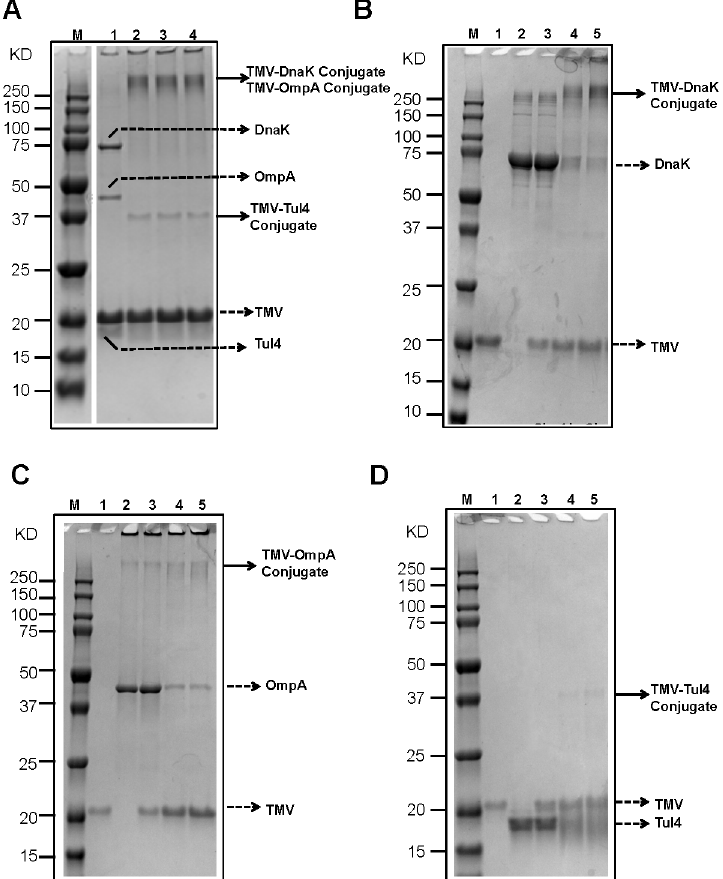
Fig 4. Conjugation of DnaK, OmpA and Tul4 Proteins of F . tularensis SchuS4 to TMV. Purified OmpA, DnaK and Tul4 proteins were combined with purified TMV and incubated with EDC and NHS for 0, 30 min, 1, or 2 hours as described in Methods section. Two μ g of TMV or recombinant proteins DnaK, OmpA, Tul4 or 4 μ g of the TMV-protein mixtures were resolved on an 8 – 16% SDS-PAGE gel to observe conjugation products indicated by changes in the molecular masses of the starting materials. (A) Conjugation of DnaK, OmpA and Tul4 to a single TMV virion to generate TMV-monoconjugate vaccine. The progress of conjugation process was observed over a period of time: Lane M = Precision Plus Dual Color standard (BioRad) Marker; Lane 1 = TMV-protein mix, 0 min; Lane 2 = TMV-protein mix, 30 min; Lane 3 = TMV-protein mix,1 hour; Lane 4 = TMV-protein mix, 2 hours. (B, C, D) Kinetics of DnaK, OmpA and Tul4 TMV-protein conjugations over a two hour incubation period to generate TMV-protein conjugates. The individual TMV- protein conjugates were then admixed to generate TMV-multiconjugate vaccine. Lane M = Precision Plus Dual Color standard (BioRad) Marker; Lane 1 = TMV; Lane 2 = Recombinant protein; Lane 3 = TMV-protein mix, 0 hour; Lane 4 = TMV-protein mix, 1 hour; Lane 5 = TMV-protein mix, 2 hours. In all cases, 2 hour time points were used for scale-up and vaccine preparation. Solid arrows indicate TMV-protein conjugate(s), dashed arrows indicate free TMV or free